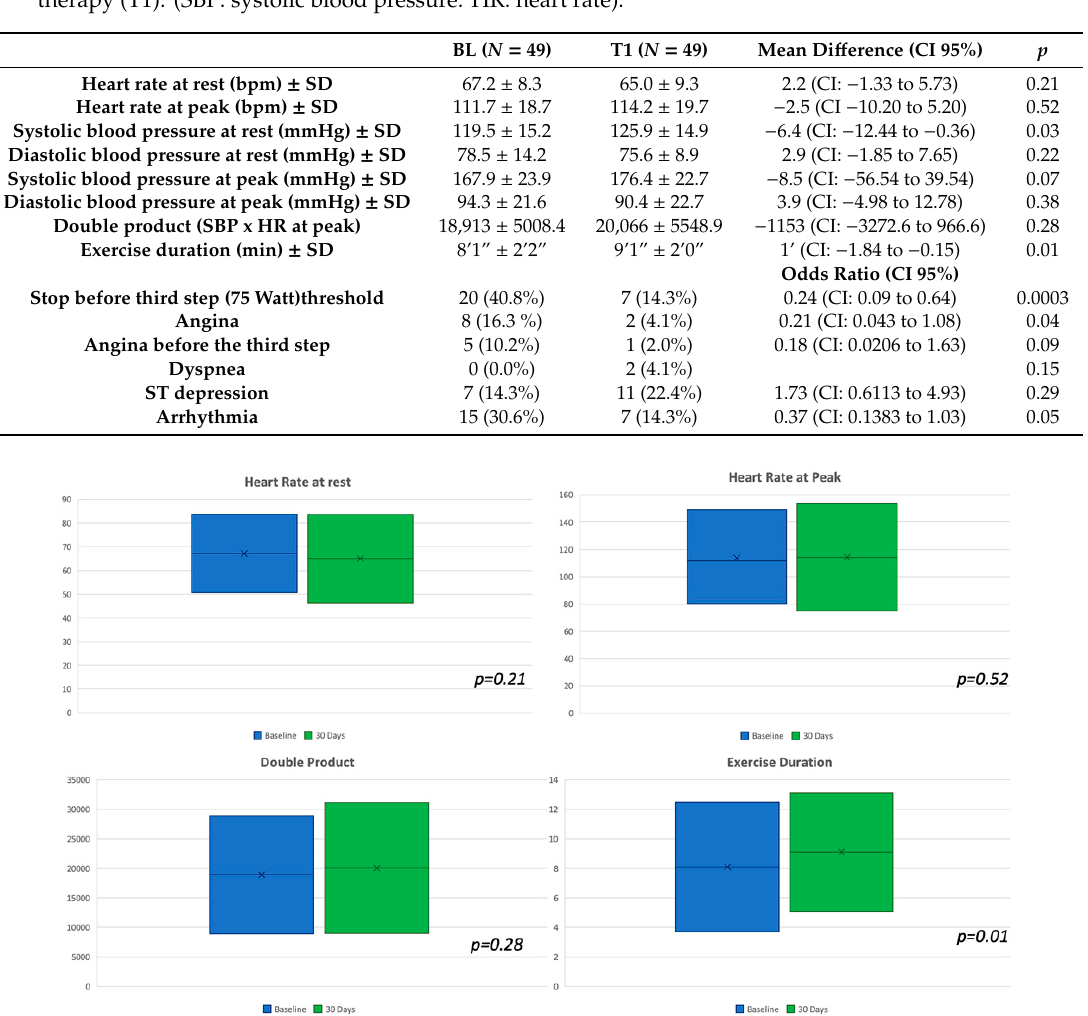
Figure 2. Graphical representations for the continuous variables at baseline and at follow-up show a significant difference in exercise duration that was increased at follow-up.